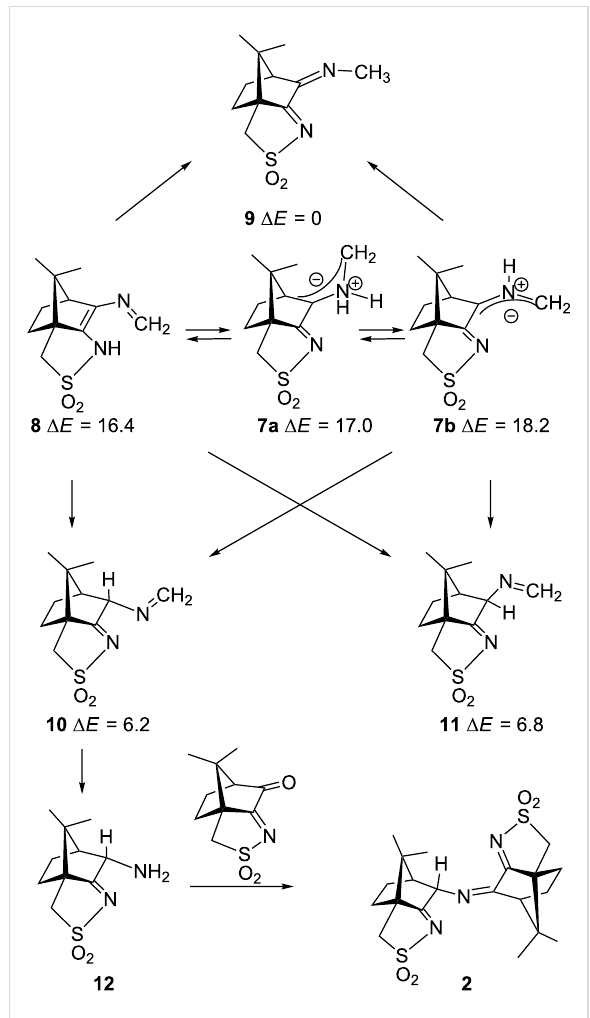
Figure 11: Potential products 7 – 11 of the Strecker degradation together with the reaction of compound 10 to give the compound 2 . ∆ E denotes the calculated energy difference (in kcal/mol) of the opti- mized geometries to the most stable one, 9 .